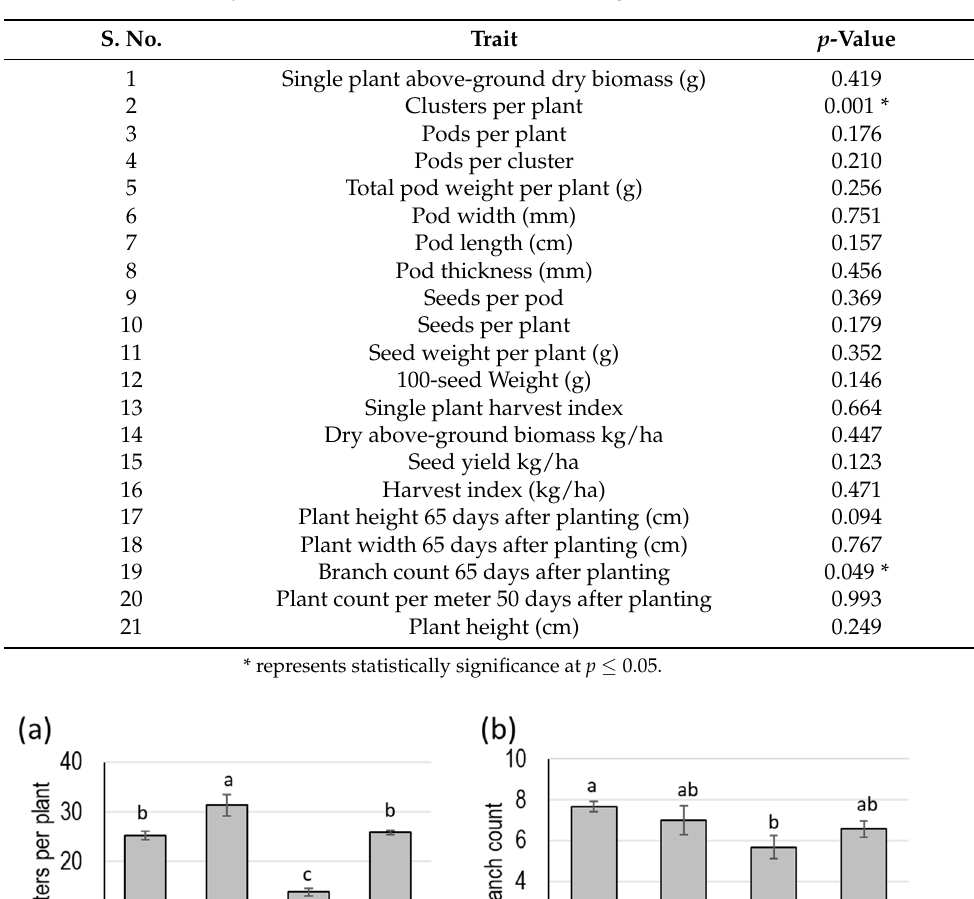
Table 2. Statistical analyses of different traits studied for four guar varieties.